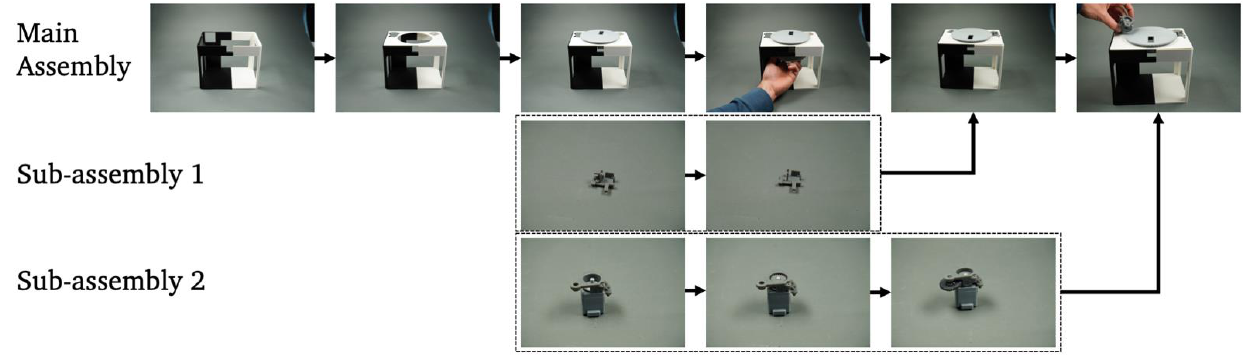
Figure 7. Steps of the assembly procedure.